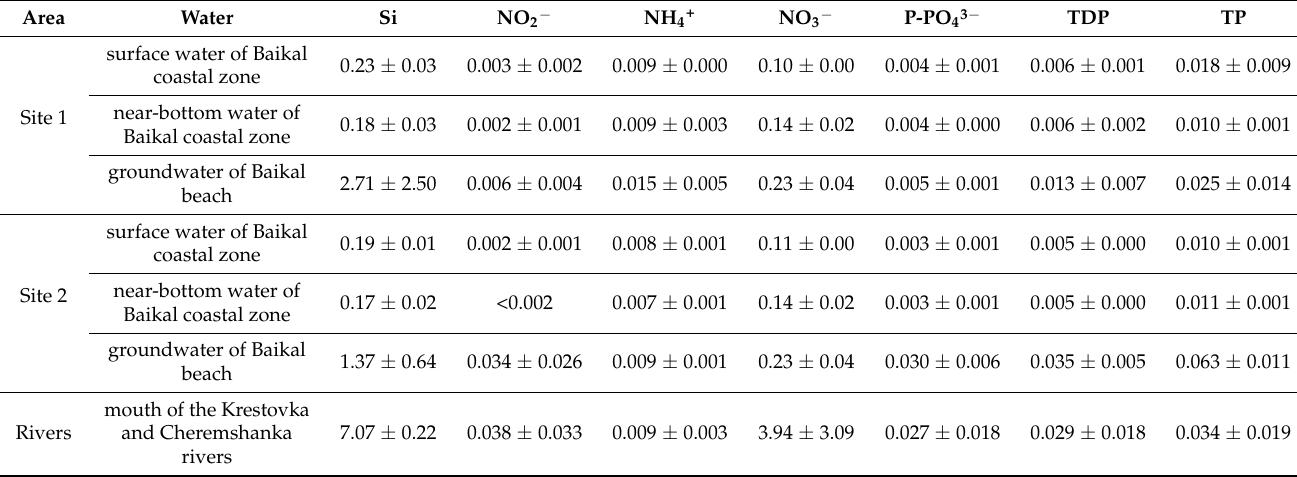
Table 1. Concentrations of nutrients (mg L − 1 ) in the water of the study area in August 2016. Site 1 included stations I, II, and III in the background area; Site 2 included stations IV, V, and VI in the area with human activity in Listvennichny Bay; TDP—total dissolved phosphorus; TP—total